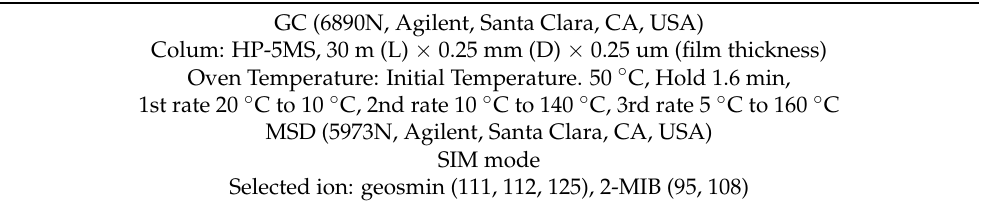
Table 2. Analytical conditions of the gas-chromatographic mass spectrometric detection (GC/MSD). GC (6890N, Agilent, Santa Clara, CA,